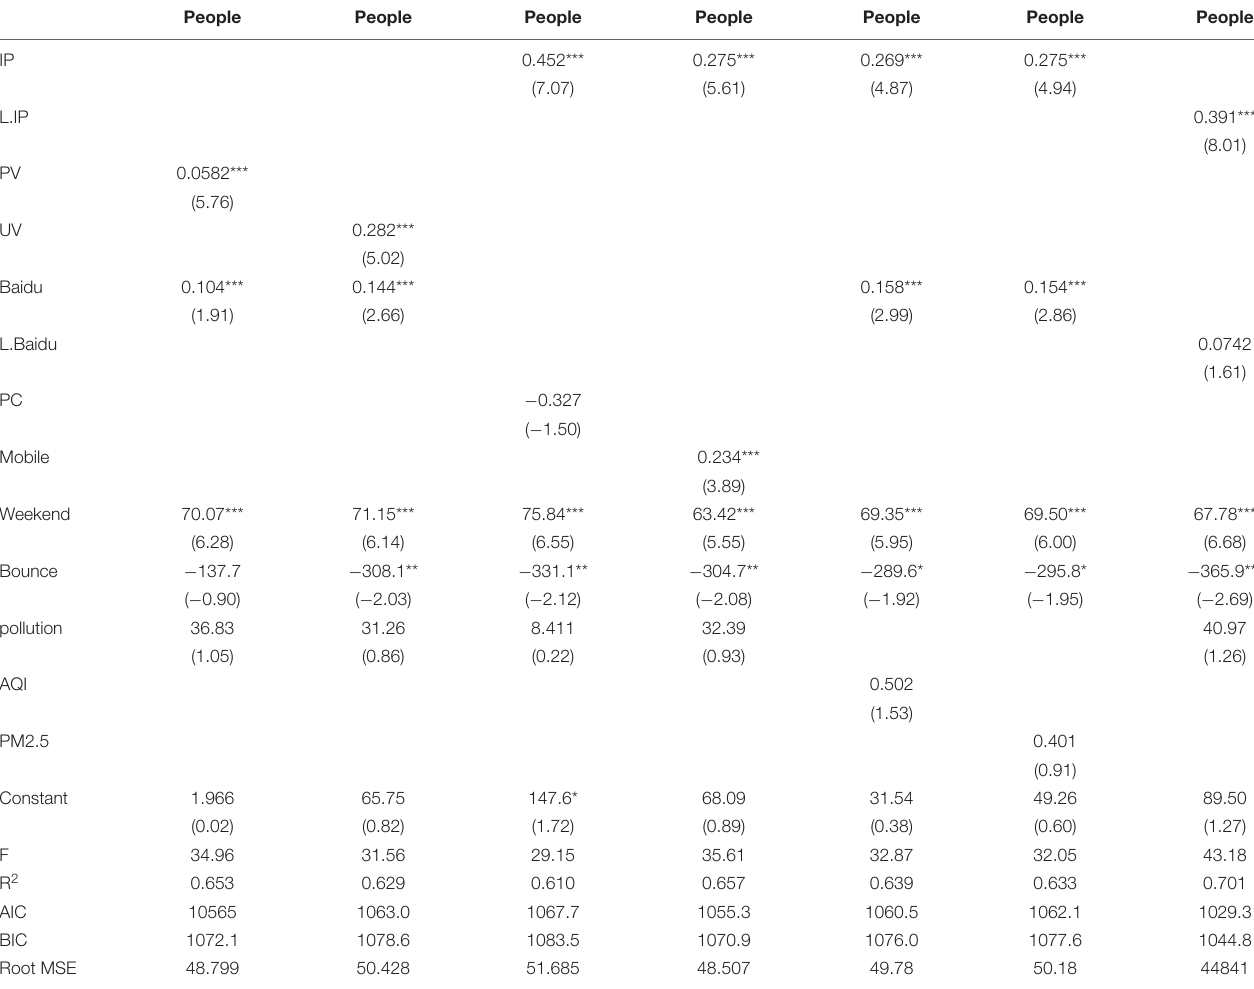
TABLE 5 | Stability